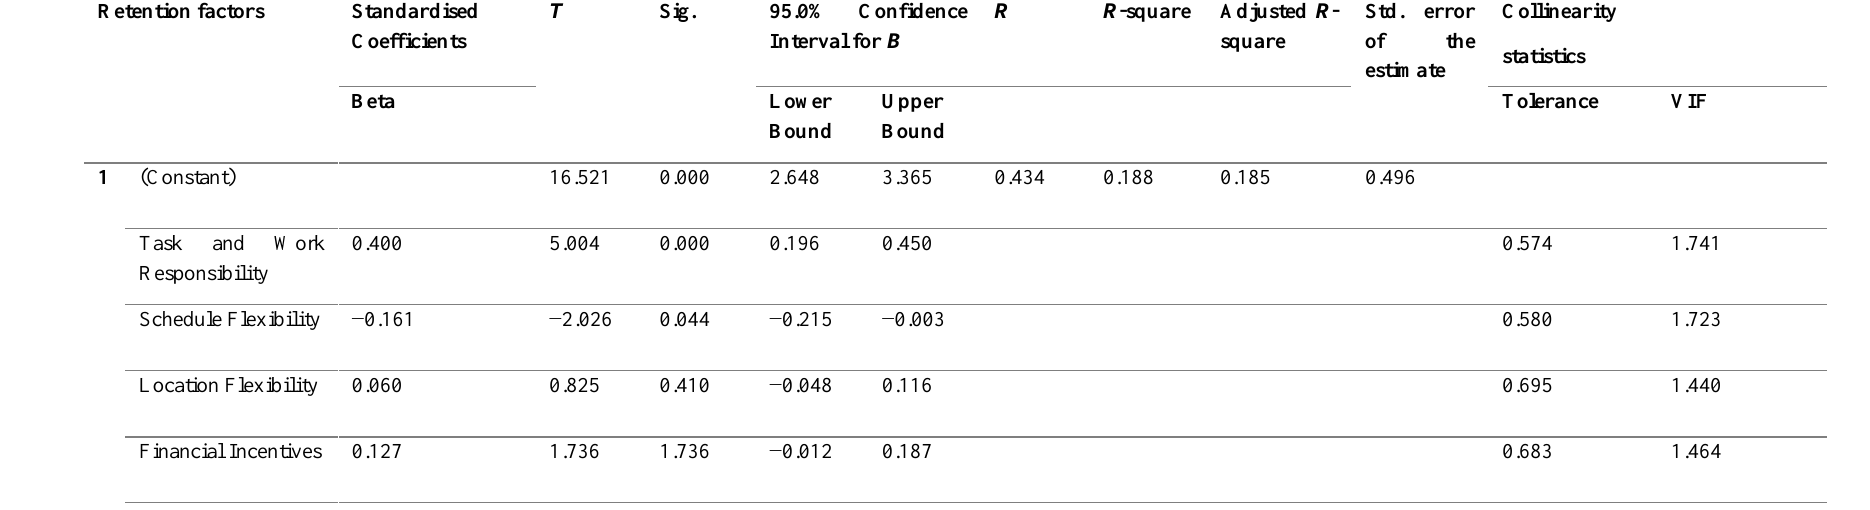
Table 3: Multiple Regression analysis of i-deals on work role